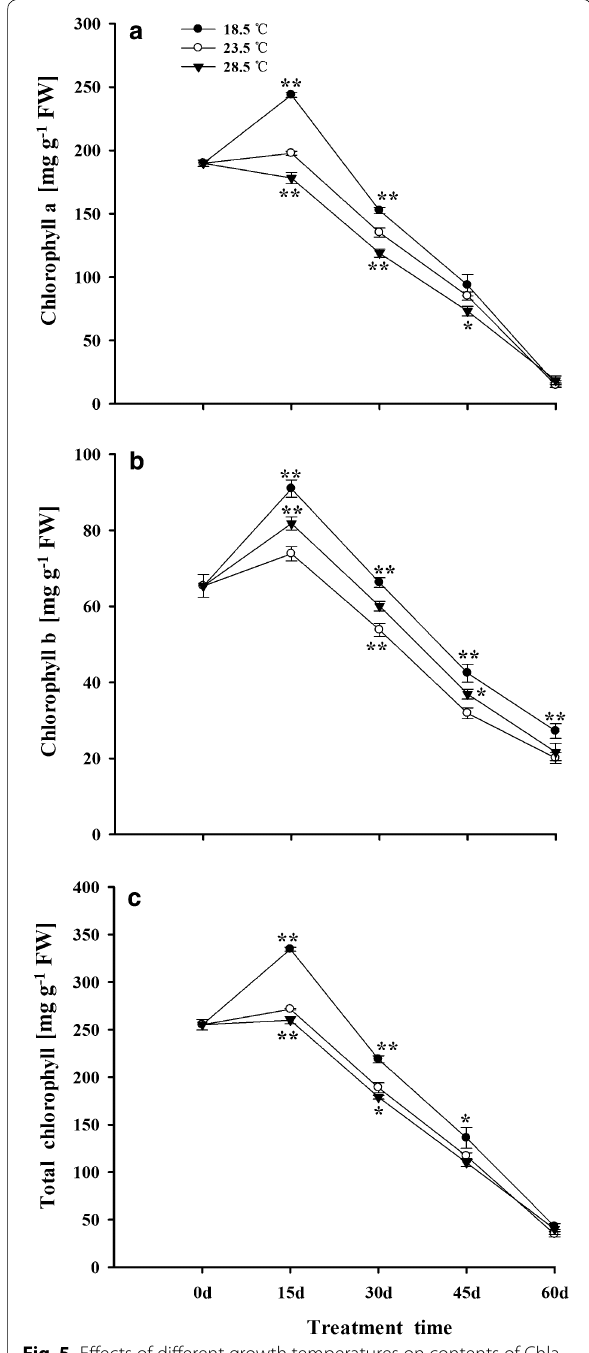
Fig. 5 Effects of different growth temperatures on contents of Chla ( a ), Chlb ( b ) and total Chl ( c ) in tobacco